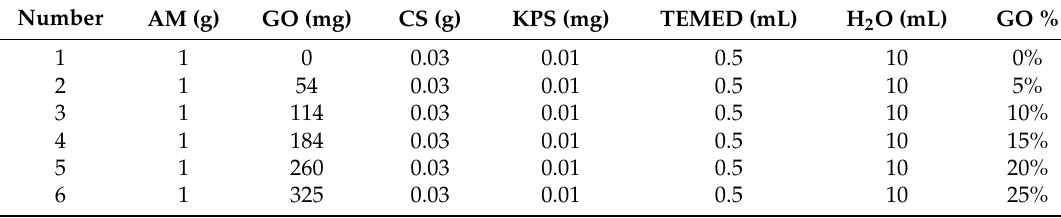
Table 1. The specific quantity of each material in CAG